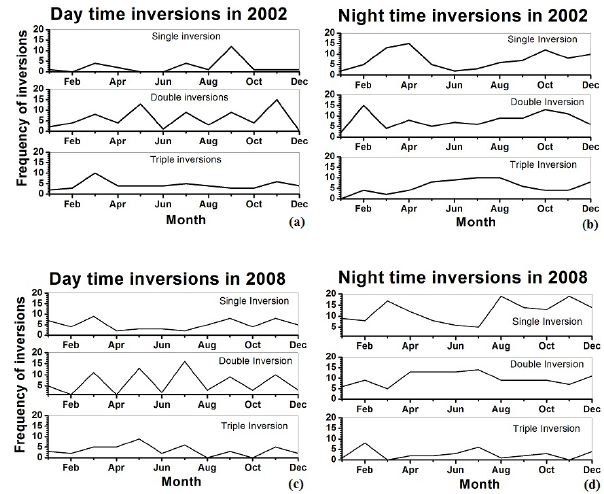
Figure 5. Occurrence characteristics of single, double and triple in- versions, during daytime (a, c) and night-time (b, d) of the year